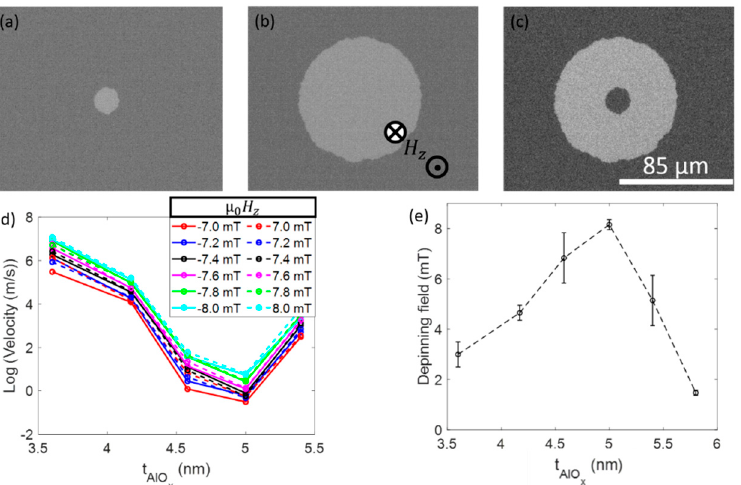
Figure 2. ( a ) Magnetic domain wall (DW) nucleated with a 1 ‐ s pulse of the OOP field H z of − 8.5 mT, acting as a reference image. ( b ) DW driven with the 8 ‐ s pulse of − 7.8 mT H z . ( c ) Differential image of DW corresponding to ( a , b ) of the Pt (4 nm)/Co (1.1 nm)/AlO x (5.8 nm) sample. ( d ) DW velocity as a function of aluminum oxide thickness, 𝑡 (cid:3002)(cid:3039)(cid:3016) , for the different OOP fields. ( e ) Plot showing depend ‐ ence of the depinning field on 𝑡 (cid:3002)(cid:3039)(cid:3016) .